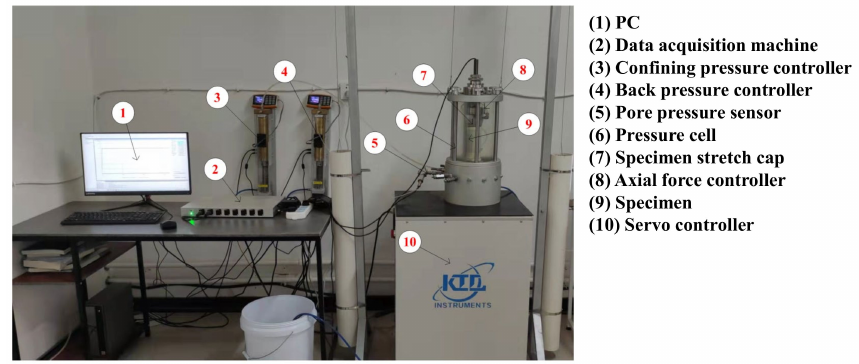
Figure 3. Cyclic triaxial test